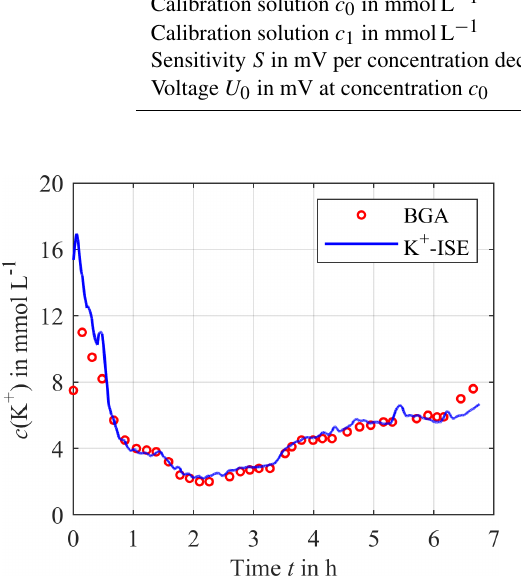
Figure 6. Continuously measured potassium concentration using the calibrated ISEs (solid blue line) compared to the blood gas ana- lyzer as a reference (red circles).